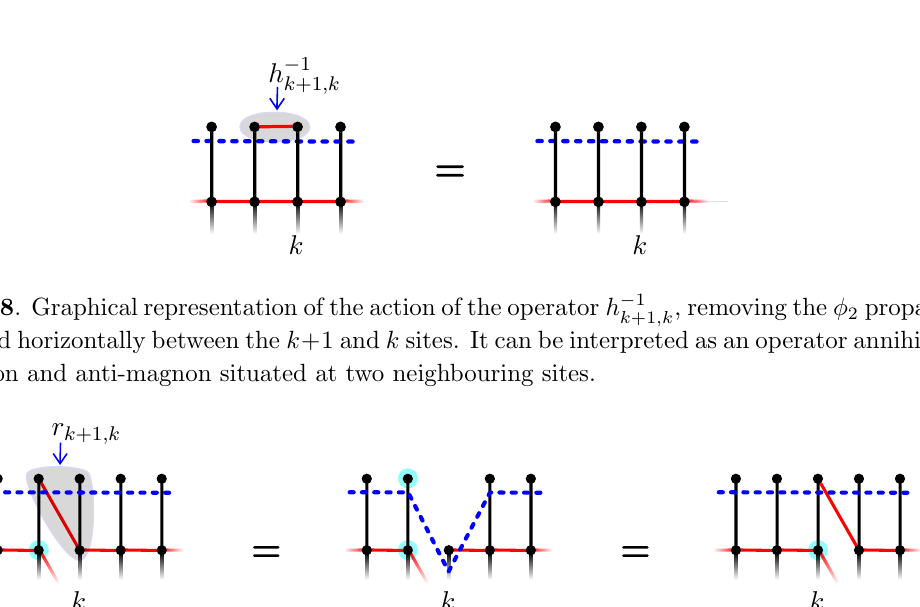
Figure 9 . The operator r k +1 ;k moves a magnon at the ( k + 1) site to the empty site on its right, ( k ). Similarly, the re(cid:13)ection of this (cid:12)gure describes how the operator (cid:22) r k +1 ;k moves an anti-magnon at the k ’th site to the empty site on its left ( k +